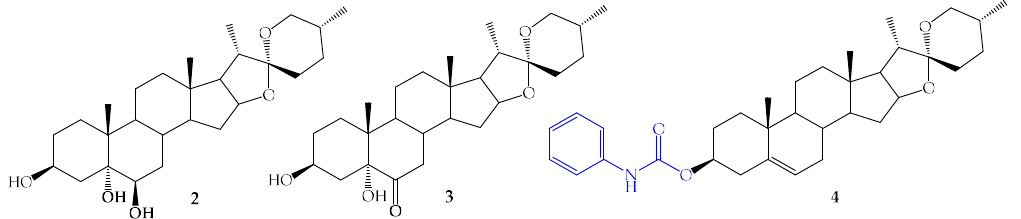
Figure 3. Diosgenin derivatives 2 and 3, and steroidal carbamate 4 .